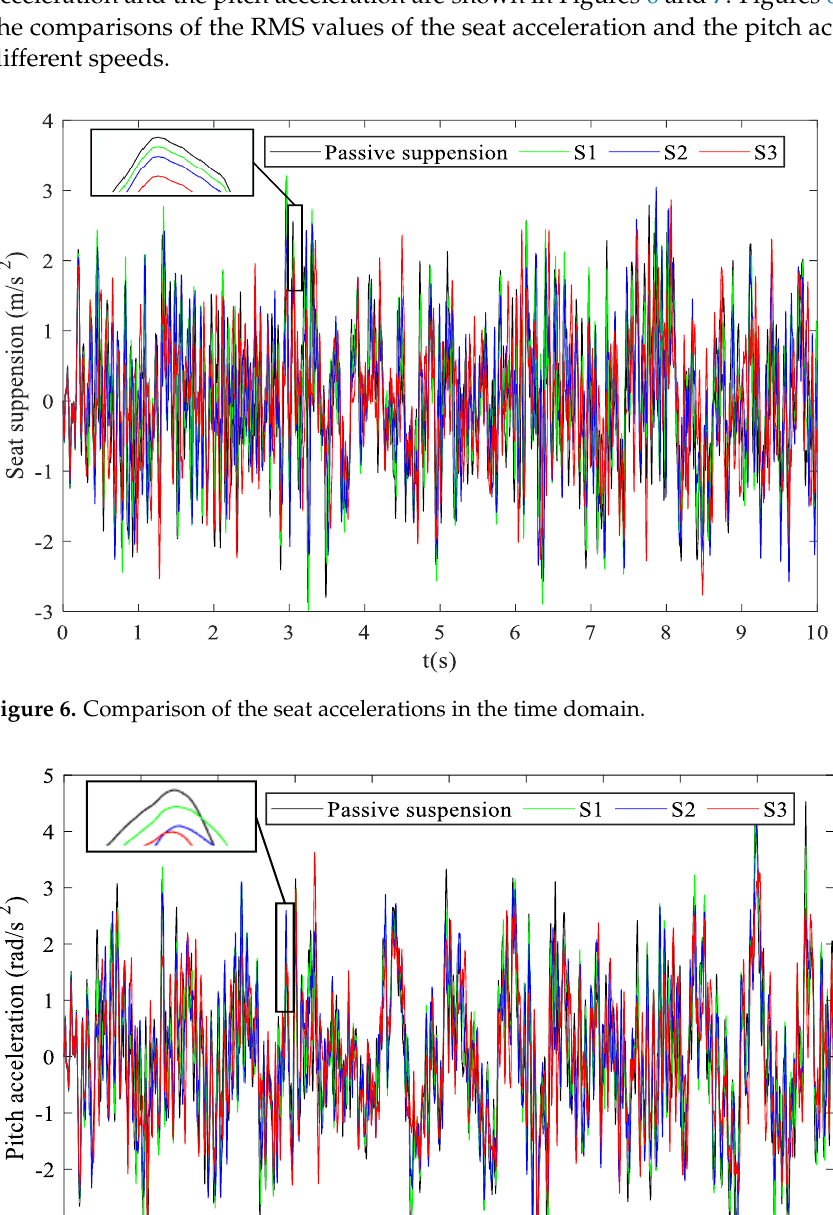
Figure 8. Comparison of the RMS of seat acceleration under different speeds.